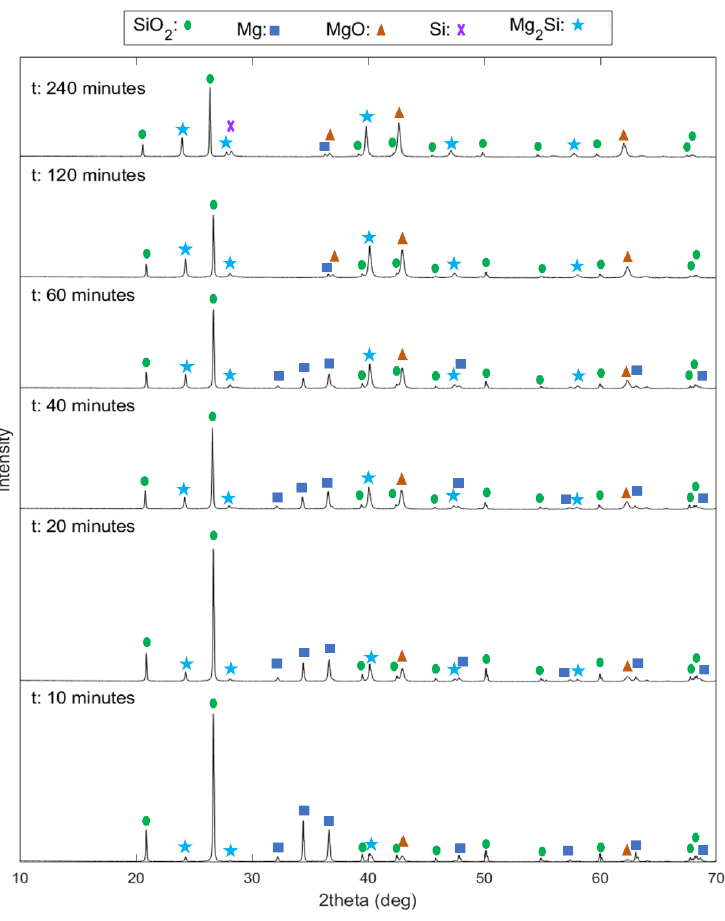
Figure 4. X-ray diffraction patterns at a Mg/SiO 2 mole ratio of 2, 1173 K and various reaction